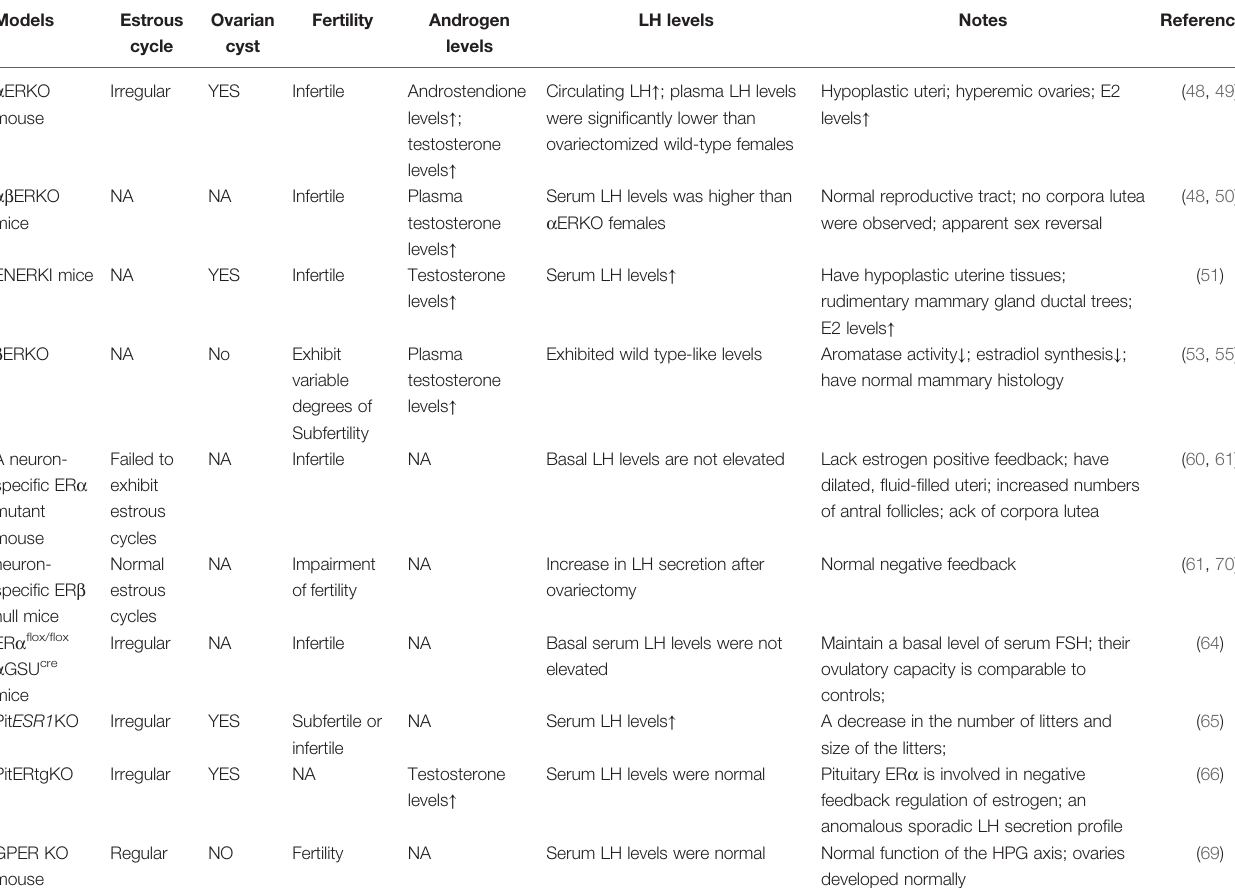
TABLE 2 | Animal models of estrogen receptors in the hypothalamic-pituitary-ovarian axis.